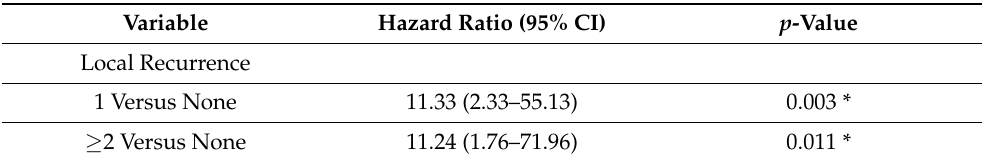
Figure 5. Malignant transformation-free survival rates of patients by the number of local recurrences. Shading around the curves represents the 95% confidence intervals (CI). Table 5. Multivariable cox regression analysis of malignant transformation-free survival in the patients with